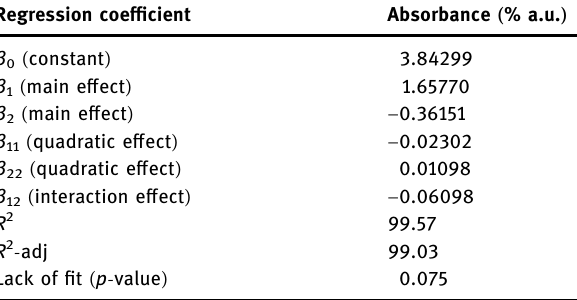
Table 2: Regression coe ffi cients, R 2 , R 2 - adj, and lack of fi t for the generated model Regression coe ffi cient Absorbance ( % a.u.